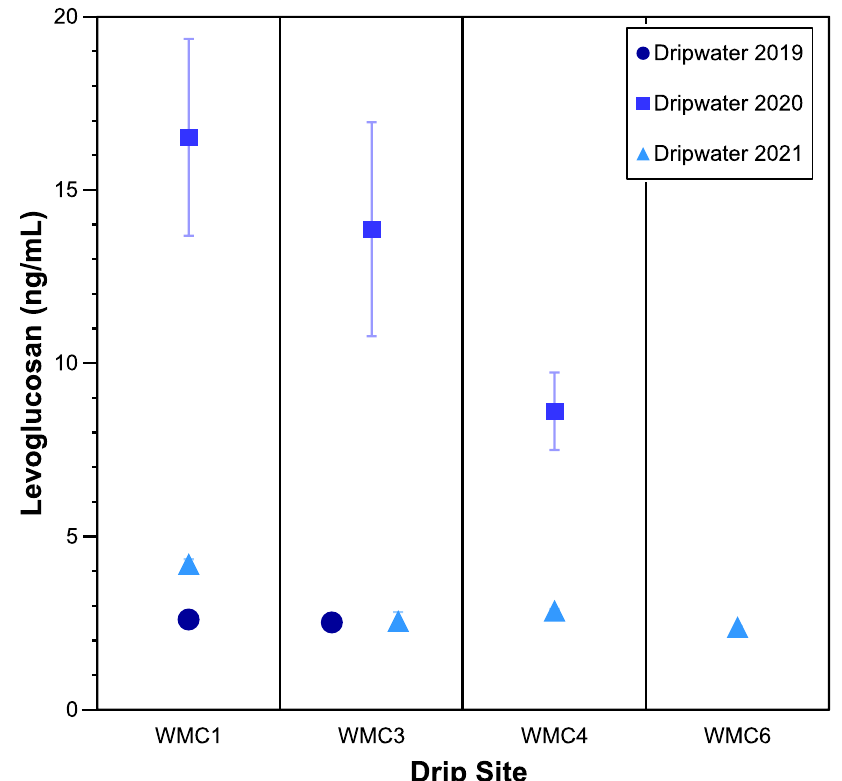
Fig. 3 | Levoglucosan concentrations in dripwater. Water samples were collected in February 2019, February 2020, and December 2021. Error bars represent the standard deviation of samples measured in duplicate and may be smaller than the